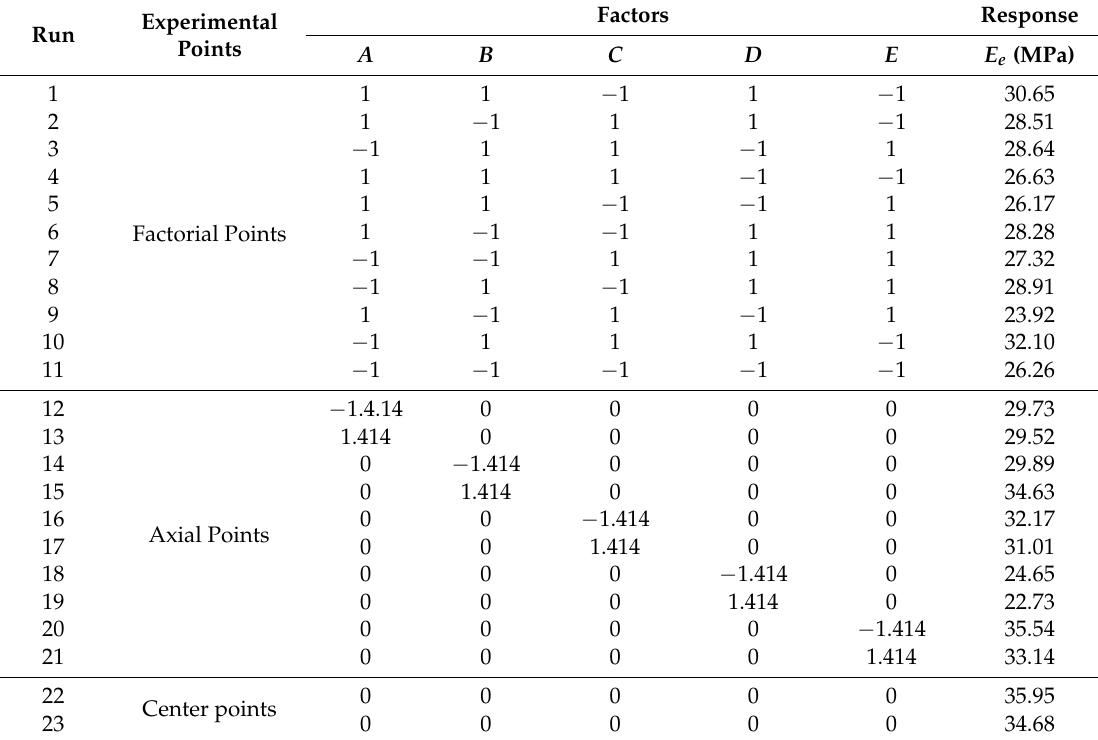
Table 5. Small fraction of CCD layout and responses of elastic modulus